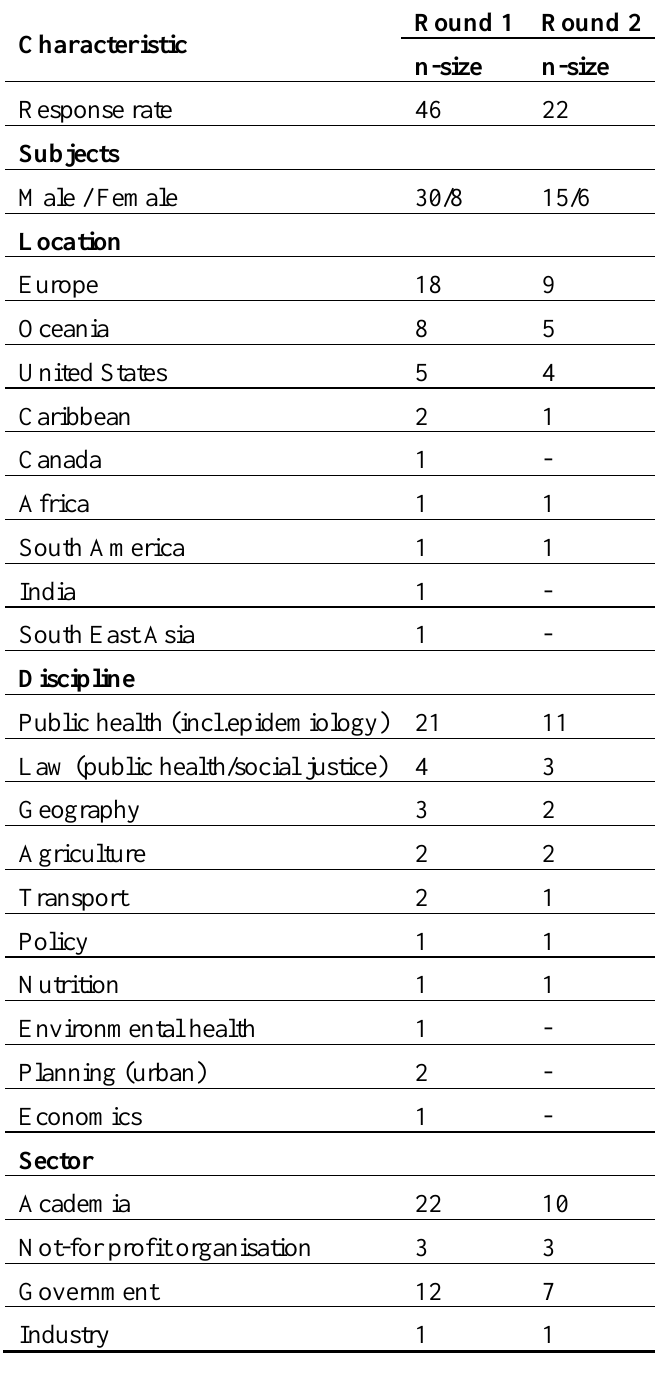
Table 1. Delphi process participant